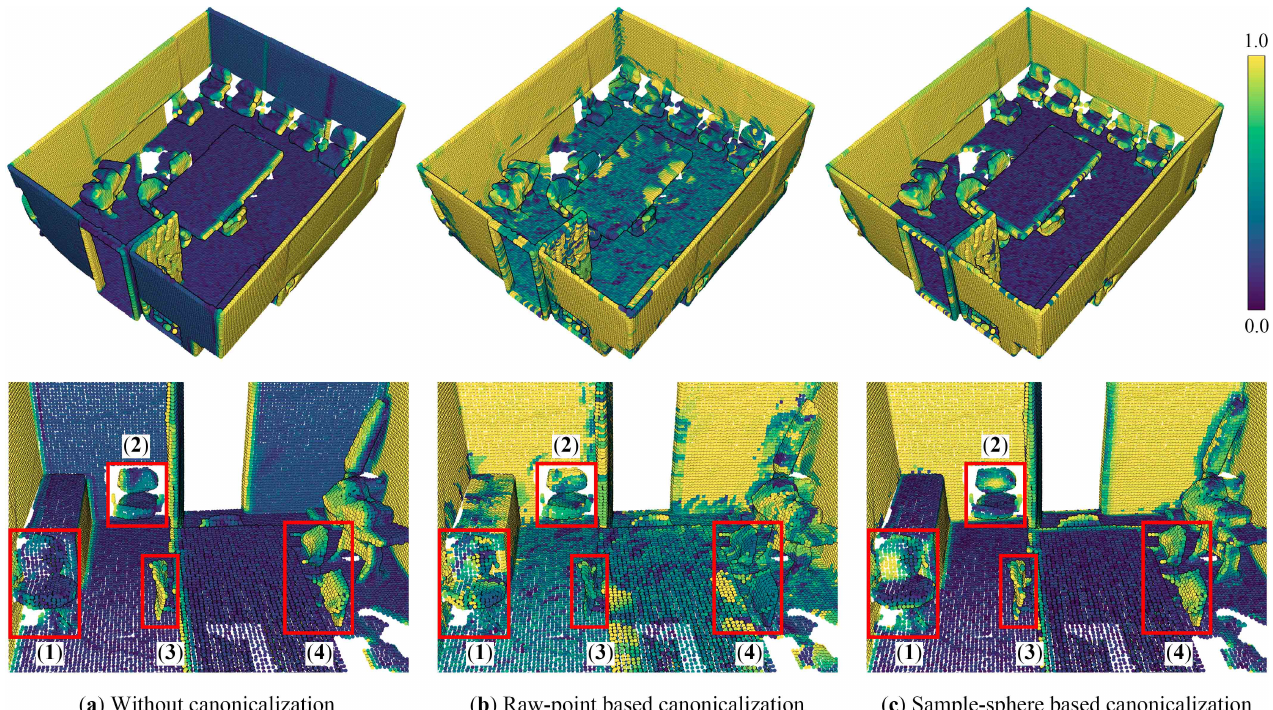
Figure 3. The impact of canonicalization on the encoded implicit features. Here we visualize the same randomly chosen dimension of the encoded implicit features under three different canonicalization settings. The four red rectangles (i.e., 1–4) in subfigures highlight noticeable differences among implicit features under different settings. ( a ) Without canonicalization, walls and chairs with the same orientation (e.g., 1 and 2) share similar implicit features, whereas those with varying orientations (e.g., 1 and 4) show different implicit features. ( b ) By transforming raw points of local neighborhoods to their canonical poses, the encoded implicit features are inconsistent. ( c ) By transforming sample spheres to their canonical poses, the implicit features become consistent and invariant to rotations (i.e., each object class has similar implicit